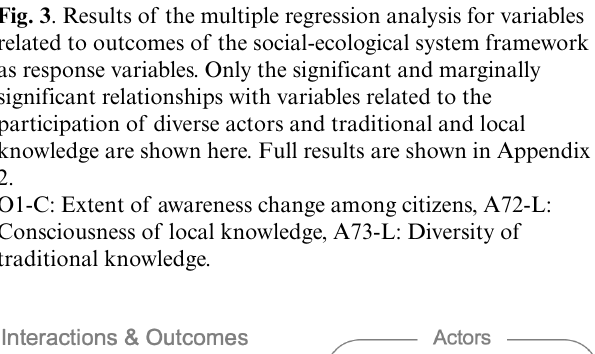
Fig. 5 . Results of the multiple regression analysis for variables related to traditional and local knowledge as response variables. shown here. Full results are shown in Appendix